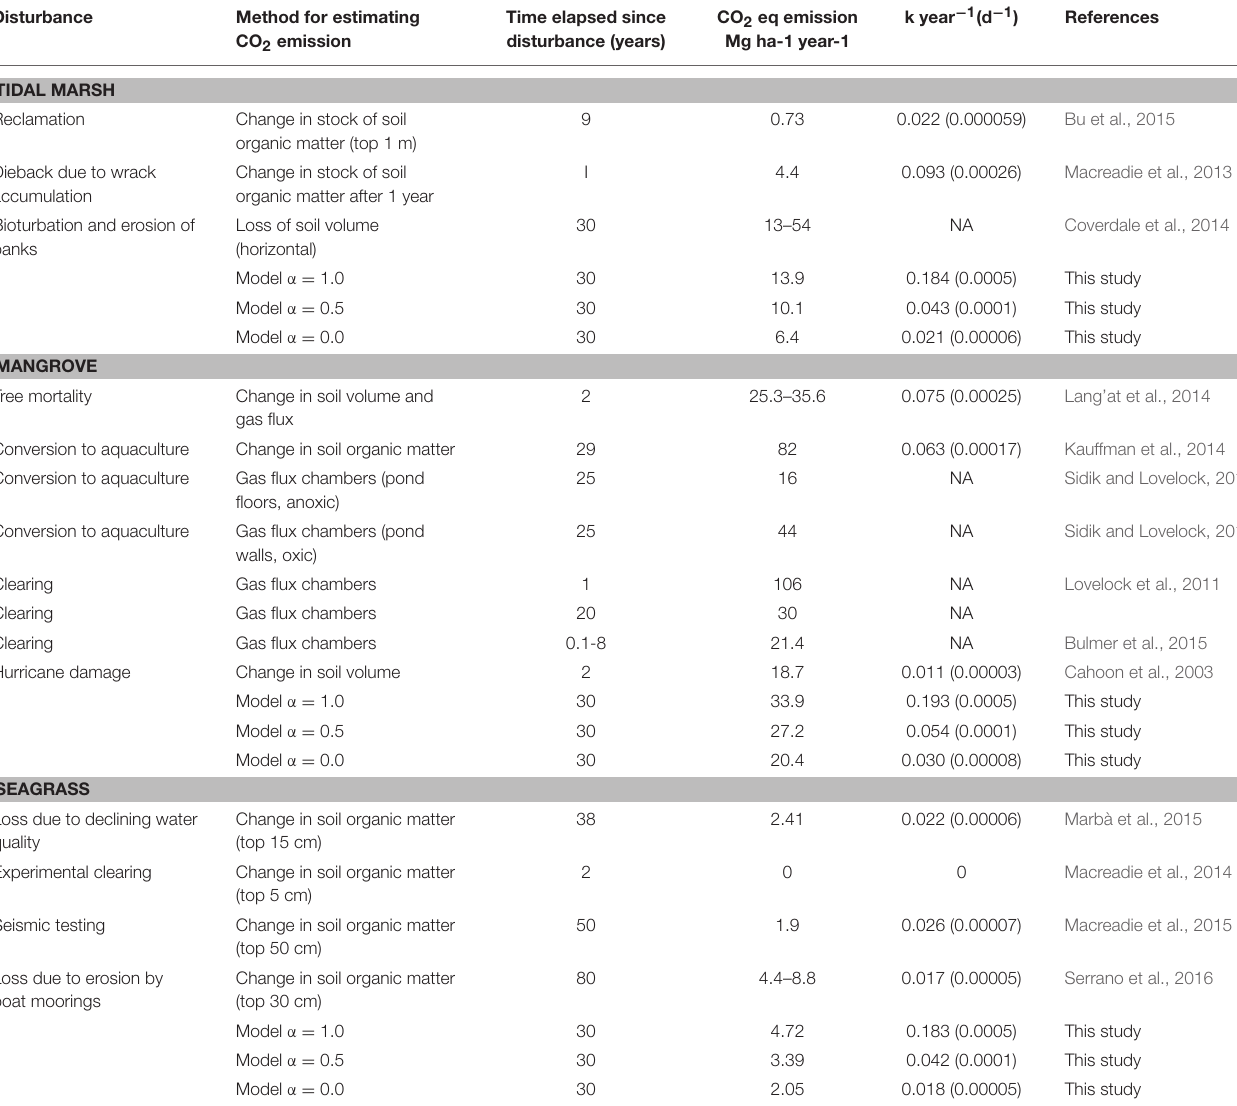
TABLE 2 | CO 2 emissions from degraded coastal wetlands reported from the literature compared to modeled results.